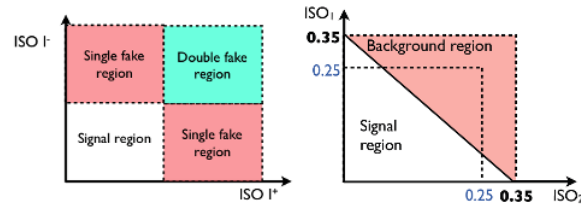
Fig. 4. Two sketches about the extrapolation from the control re- gion to the signal one for the evaluation of the Z + jets event yield. Left: the CR, called ‘Double fake region’, is shown in green, the + ISO SR in white. Right: the SR is defined by ISO (cid:96) (cid:96) 4 < 0 . 35. 3 √ s = 7 TeV , 7 Exclusion limits for L = 1 . 66 fb − 1 √ s = 7 TeV and L = 1 . 66 fb − 1 , the search for a With SM-like Higgs boson performed in the H → ZZ ( ∗ ) → 4 (cid:96) channel allows to set 95% CL upper limits on σ · BR that exclude cross sections from about one to two times the ex- pected SM ones in the mass range 150 < m H < 420 GeV / c 2 .